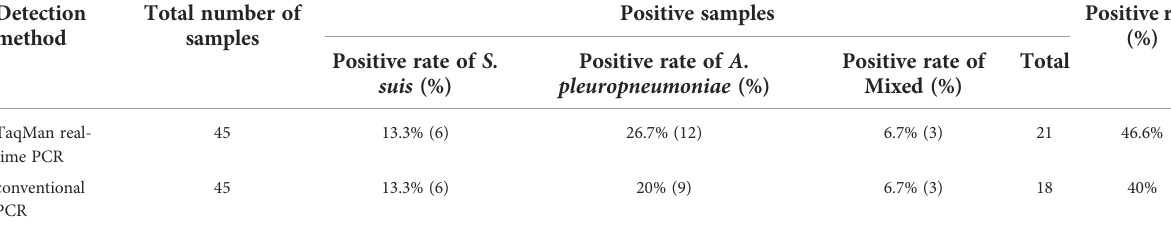
TABLE 3 TaqMan real-time PCR and conventional PCR test